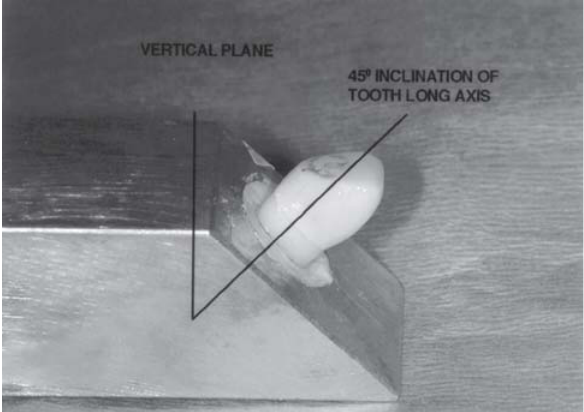
FIGURE 3- Specimen embedded in acrylic resin in the aluminum block. Lines define the inclination of tooth long